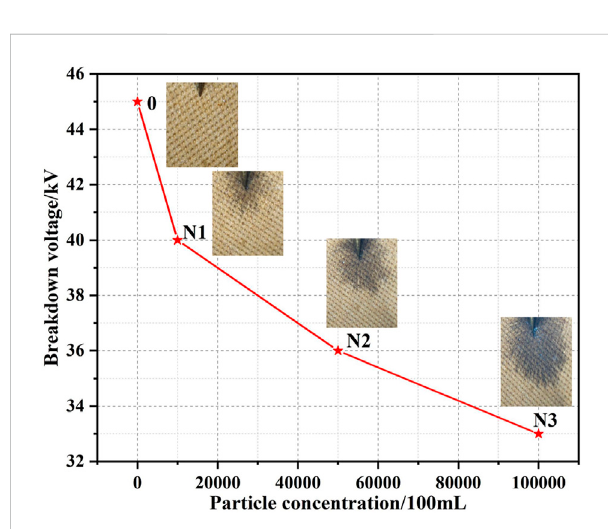
FIGURE 11 Trend of surface breakdown voltage with particle